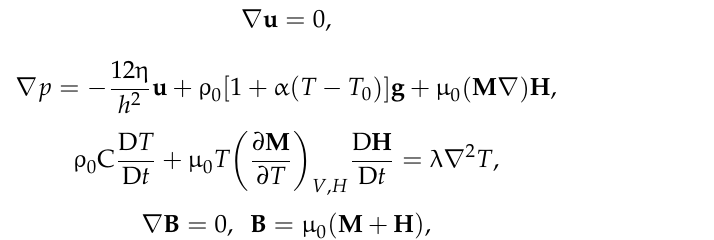
Figure 9. The time dependence of the rate of change in the normalized temperature difference between the bottom and top plates of the cell during cooling process. The results obtained in the absence and under the influence of a magnetic field are shown.